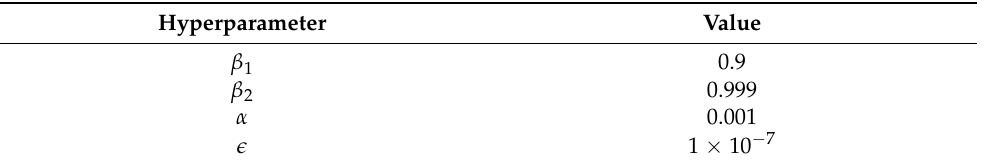
Table 5. Values of hyperparameters used in Adam